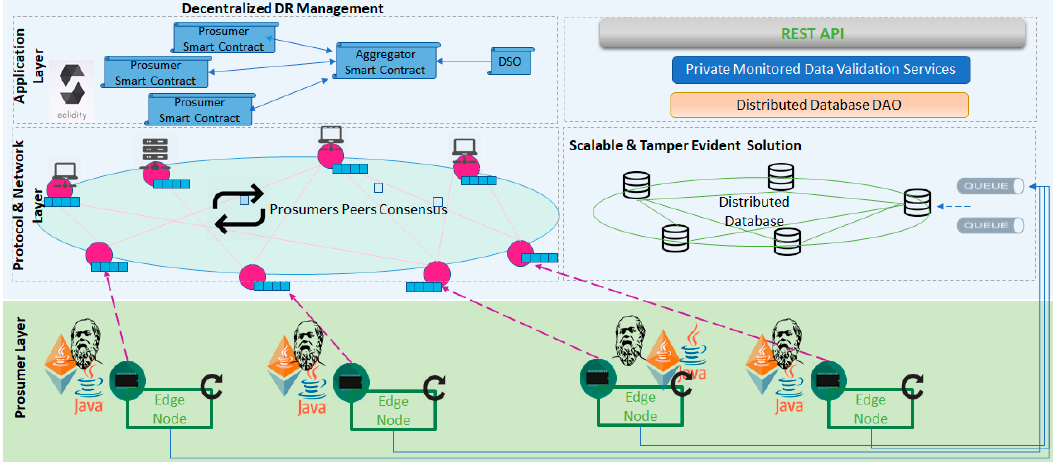
Figure 9. Prototype architecture and technologies mapping.